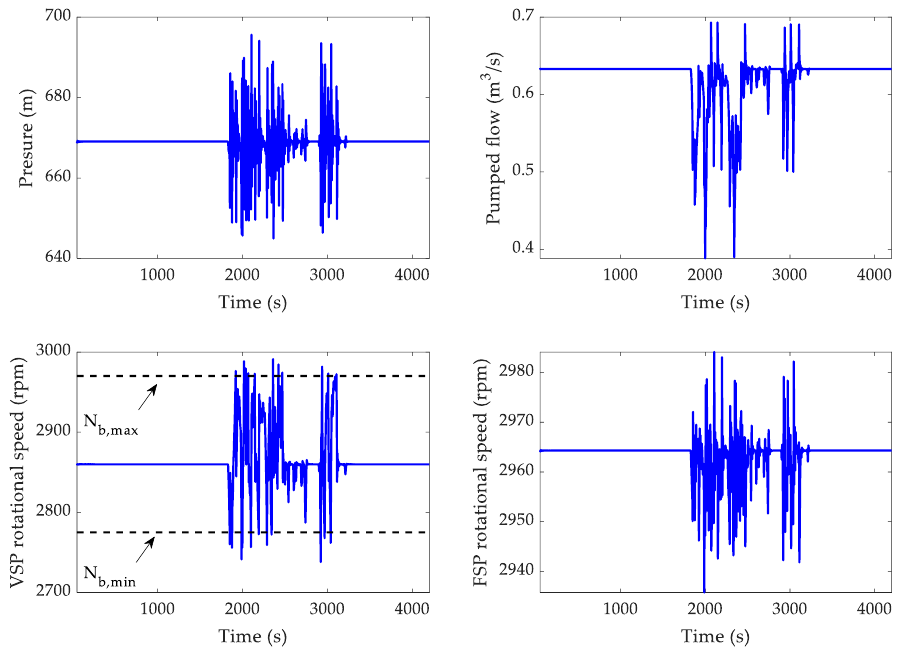
Figure 9. Pressure and flow in the penstock and pumps rotational speed when a wind speed fluctuation is simulated.